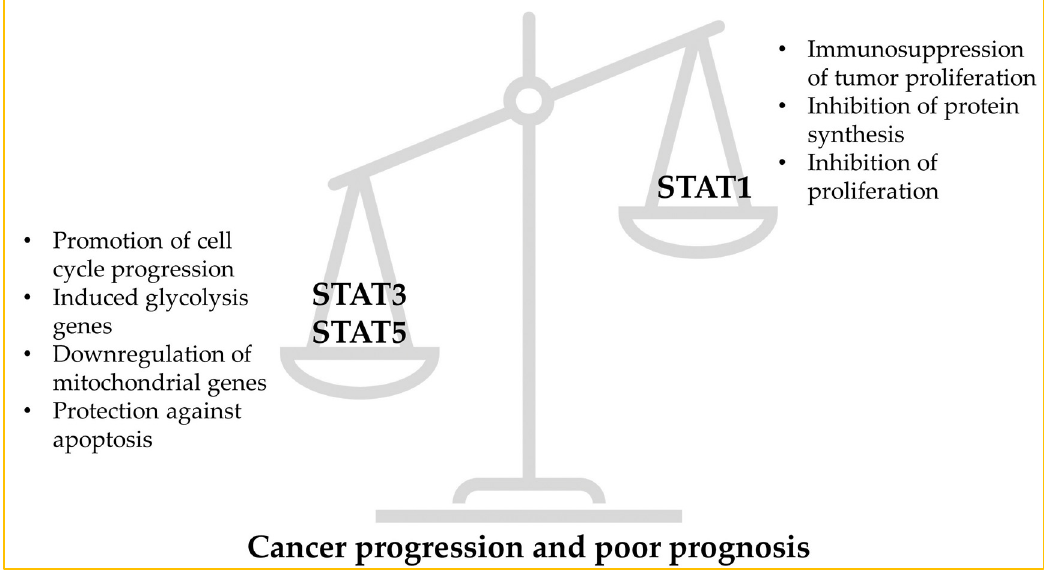
Figure 3. Effects of STAT1/3/5 in cancer progression and poor prognosis of patients.